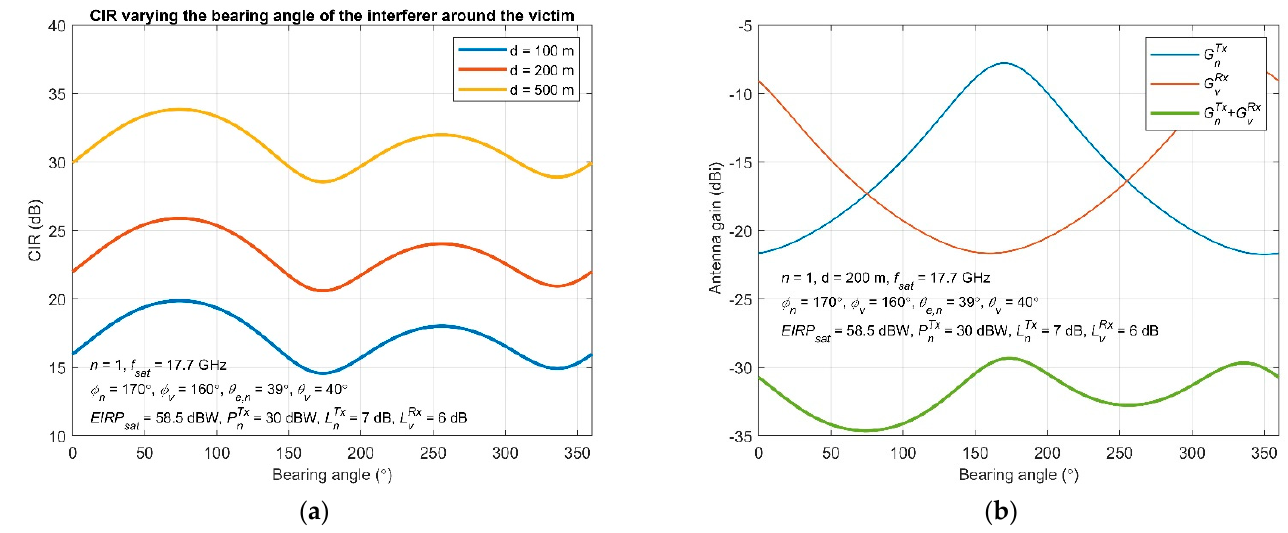
Figure 7. Achieved CIR by changing the location of the interfering station around the victim: ( a ) varying the bearing angle around the victim for diverse separation distance; ( b ) antenna gain variations with respect to the bearing angle.